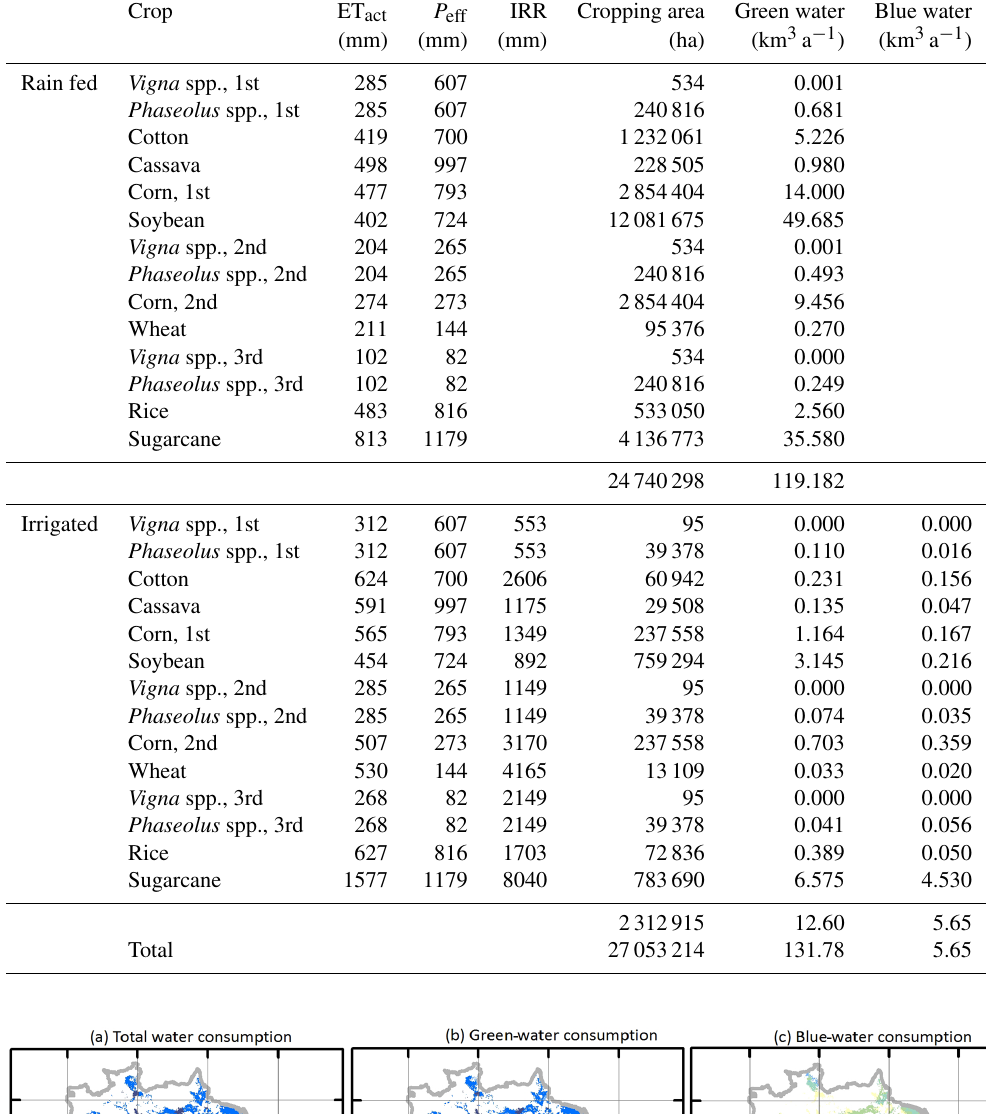
Table 3. Crop water balance and water consumption of rain-fed and irrigated crops in the Cerrado region of Brazil for the production year 2012. “1st”, “2nd” and “3rd” are the first, second and third planting dates for successive multiple cropping practices within one growing season. Crop development stages are provided in Table A1, and planting and harvesting dates are provided in Table A2.